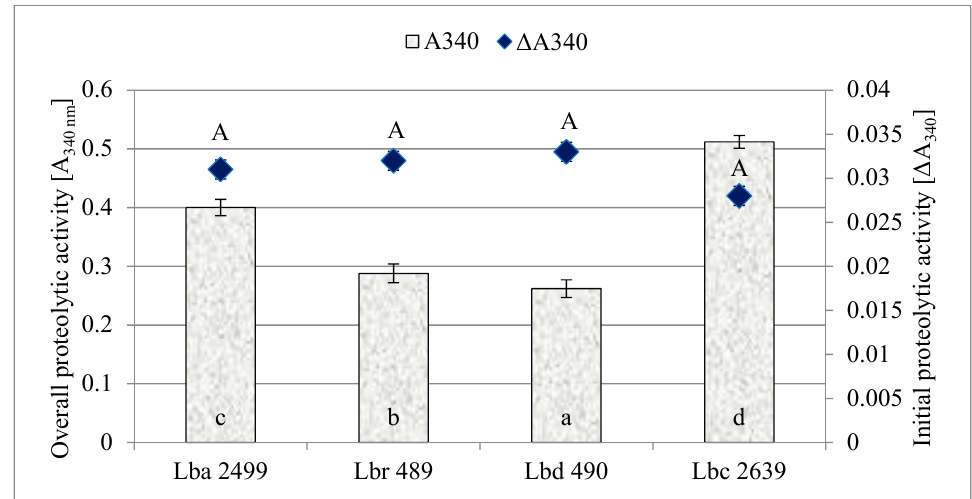
Figure 1. Initial and overall proteolytic activity of examined Lactobacillus strains (mean values and standard deviations). A: homogenous group initial proteolysis, n = 6; a–d: homogenous groups overall proteolysis, n = 6).